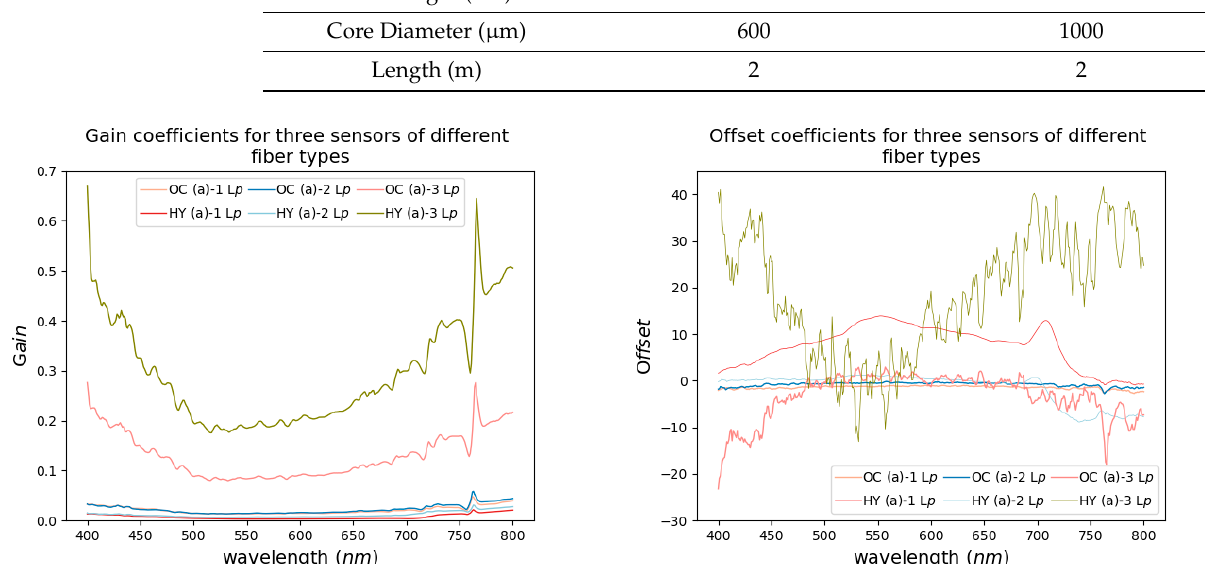
Figure 4. Graphs of gain and offset of micro-spectrometer connection with different fiber types.